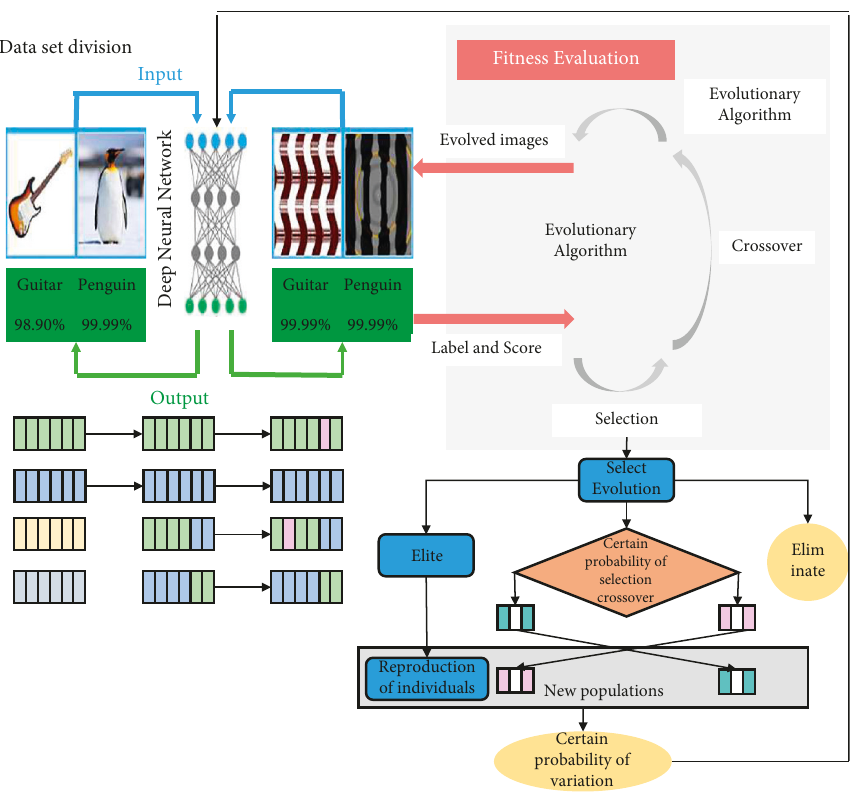
Figure 1: The digital environment art design scheme based on the genetic